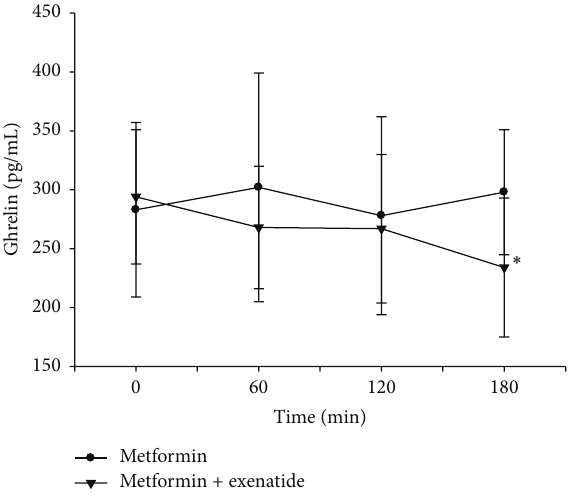
Figure 3: Serum ghrelin levels following mixed meal test with and without exenatide usage. ∗ 𝑝 < 0.05 when the percentage changes in serum ghrelin levels of two treatments were